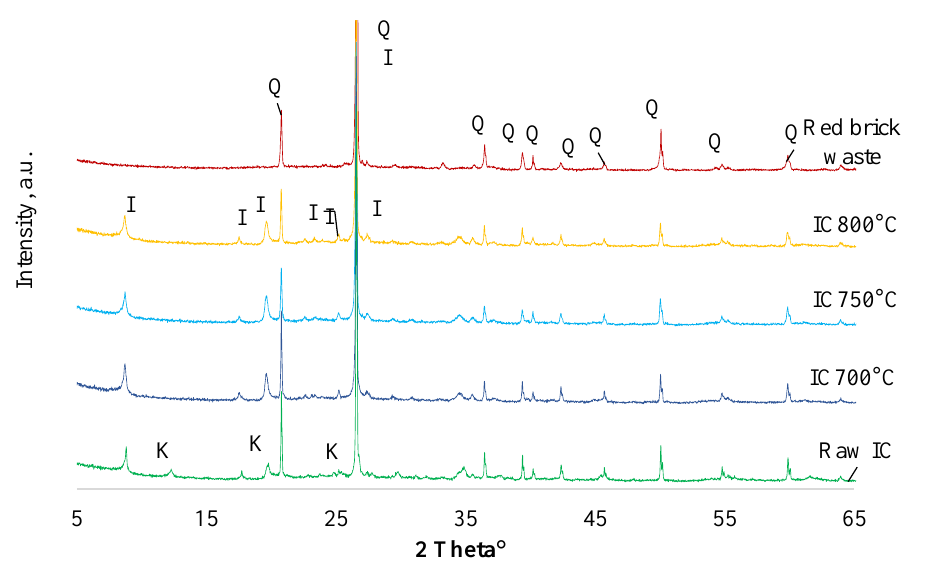
Figure 3. The XRD patterns of raw IC, red brick waste, and calcined red clay at different temperatures. Notes: Q is quartz SiO 2 (77-1060), I is illite (26-911), K is kaolinite (83-971).